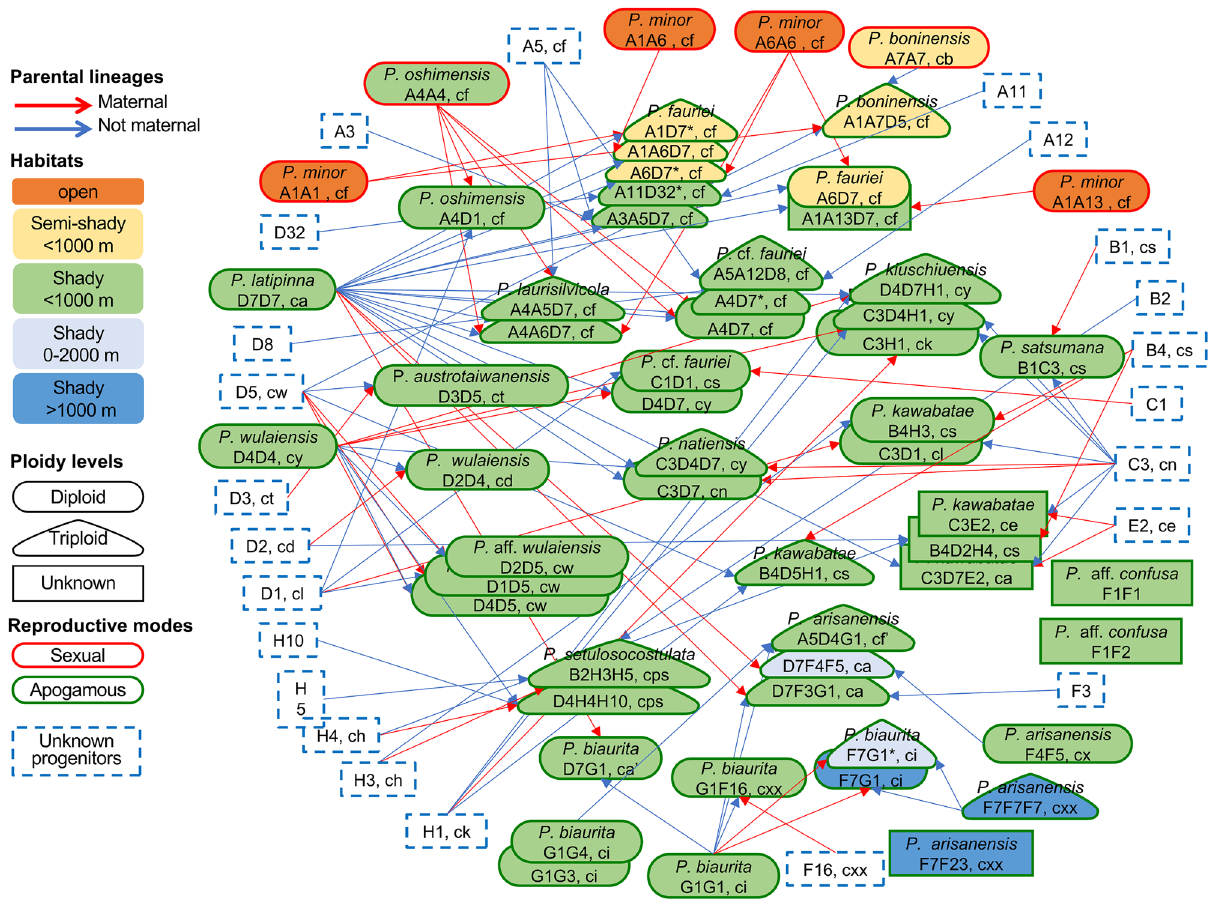
Figure 5. A reticulogram of the Pteris fauriei group, based on the Knox3 sequences. The taxa correspond to the genotypes in Table 1. Maternal contributors of hybrids are shown as red arrows and paternal contributors as blue arrows. Ploidy levels are indicated by symbols: ellipse for diploids, triangle for triploids, and rectangle for unknown ploidy. Different kind of habitats are separated by colors inside symbols. Red or green symbol outlines indicate reproductive mode (sex and apogamy, respectively). Undiscovered taxa have dashed-lined outlines. Alleles of Knox3 and cpDNA haplotypes of each taxon are also